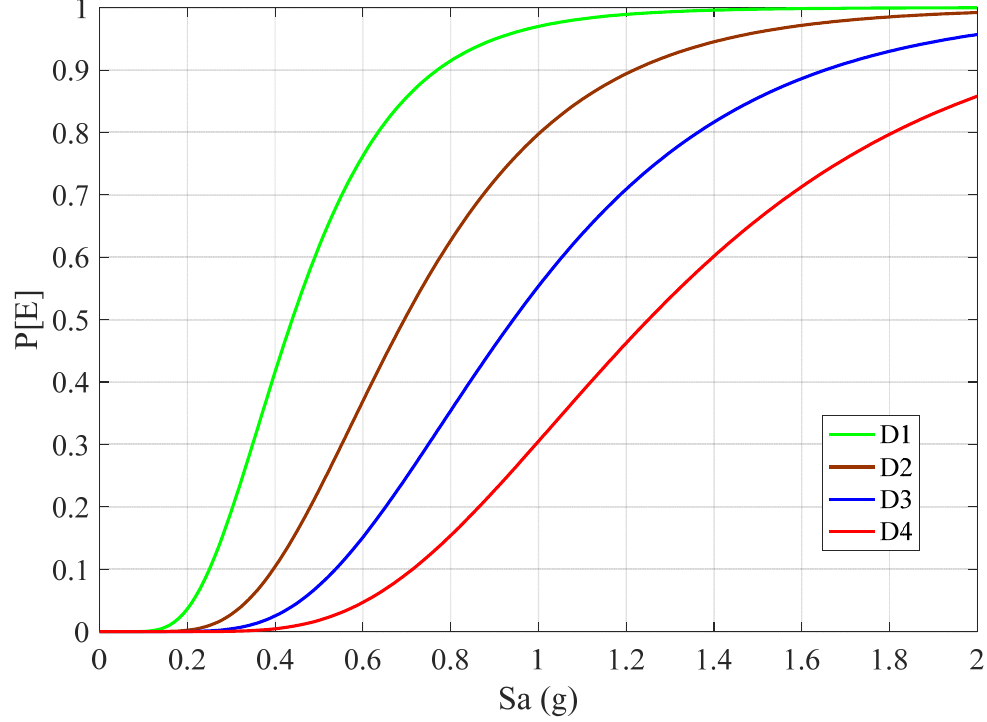
Figure 10. Foreshock–mainshock–aftershock fragility functions for low-rise SMRF buildings.